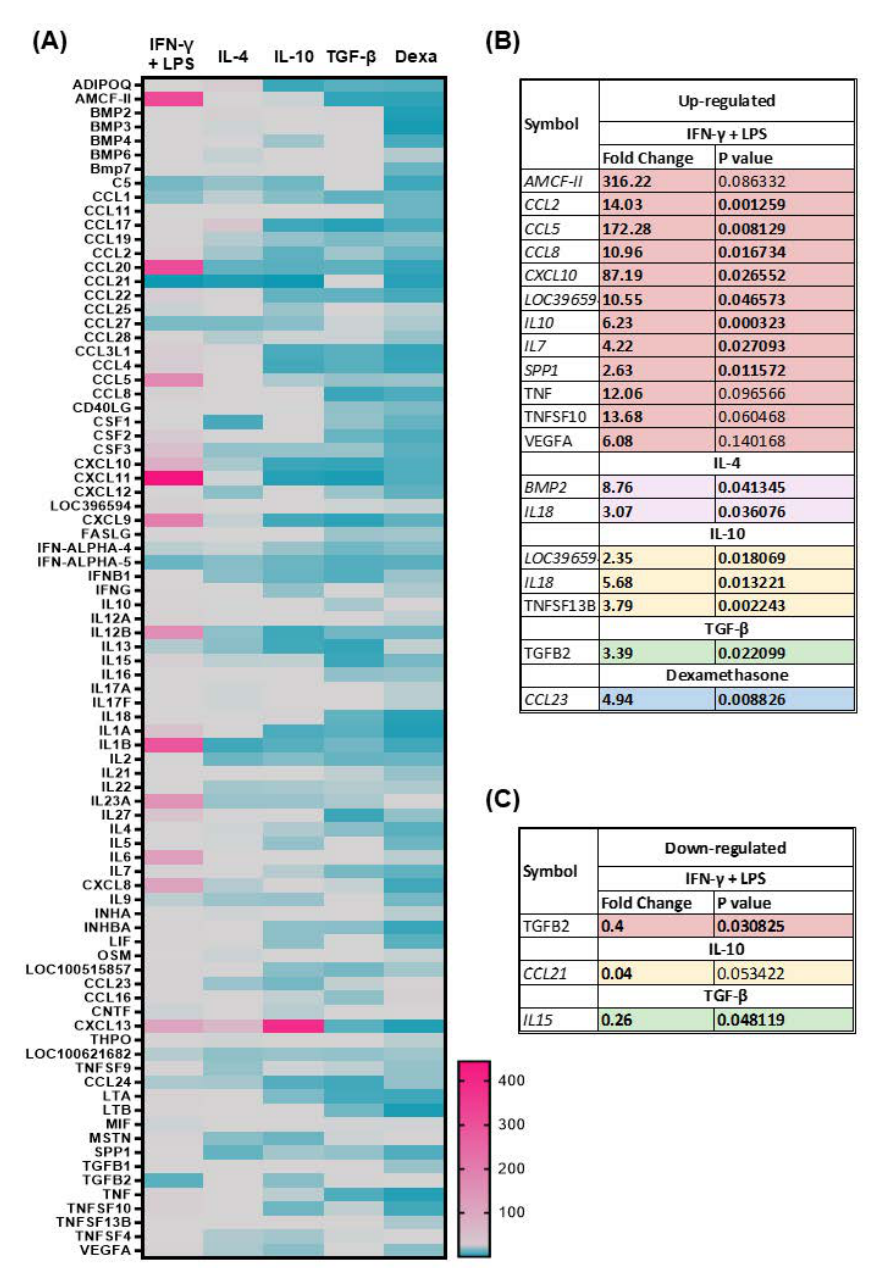
Figure 3. Modulation of 84 genes in moM Φ stimulated with diverse polarizing factors. Porcine moM Φ were left untreated, or they were stimulated with diverse polarizing factors: IFN- γ + LPS (both at 100 ng/mL), IL-4 (20 ng/mL), IL-10 (20 ng/mL), TGF- β (20 ng/mL), or dexamethasone (“DEXA”, 20 ng/mL). Then, 24 h post-stimulation, macrophage subsets were analyzed using the RT2 Profiler PCR Array for 84 common immune-related genes: ( A ) The heatmap illustrates fold change expression of these 84 immune-related genes, obtained from macrophage subsets from three diverse pig blood donors. For each macrophage subset, fold change in gene expression was calculated relative to the untreated control (moM Φ ). The colors represent the fold change in gene expression compared to the untreated control, with the brightest pink representing the highest value, light grey representing the baseline value (fold change = 1), and blue representing the smallest value; ( B ) for each macrophage subsets, statistically significantly upregulated genes (fold change > 2, p -value < 0.05) are presented, with the corresponding fold change and p -value; ( C ) for each macrophage subsets, statistically significantly downregulated genes (fold change > 2, p -value < 0.05) are presented, with the corresponding fold change and p